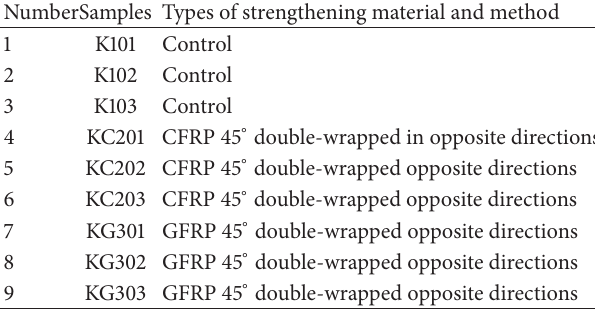
Table 4: Strengthening of the sample